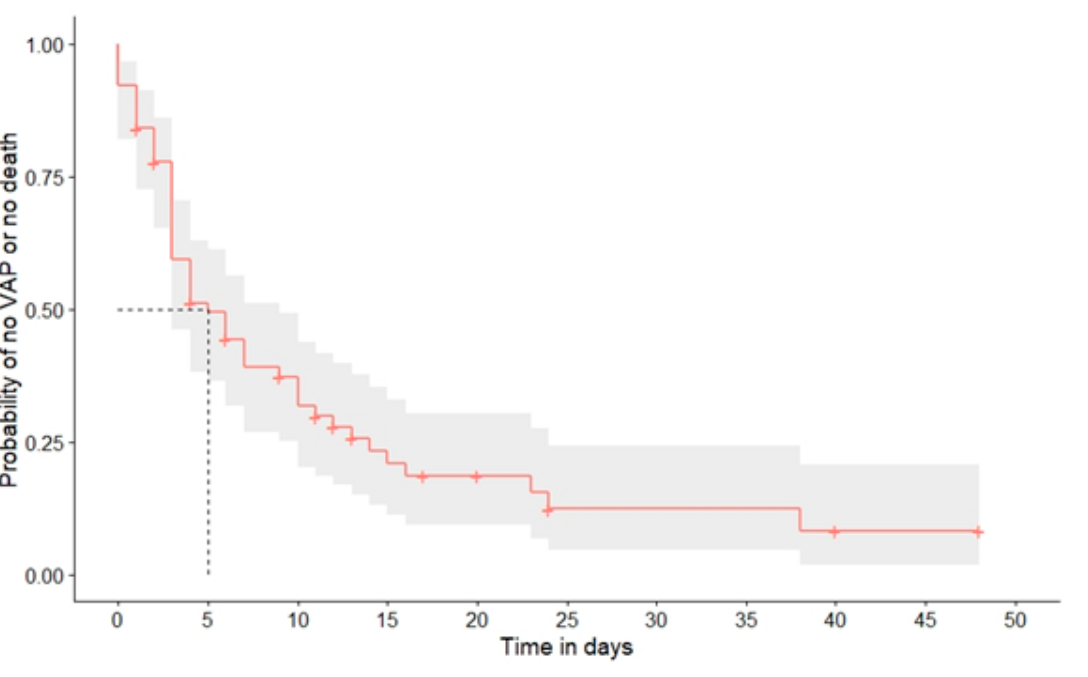
Figure 1. Risk of developing VAP (ventilator-associated pneumonia) or dying after intubation.